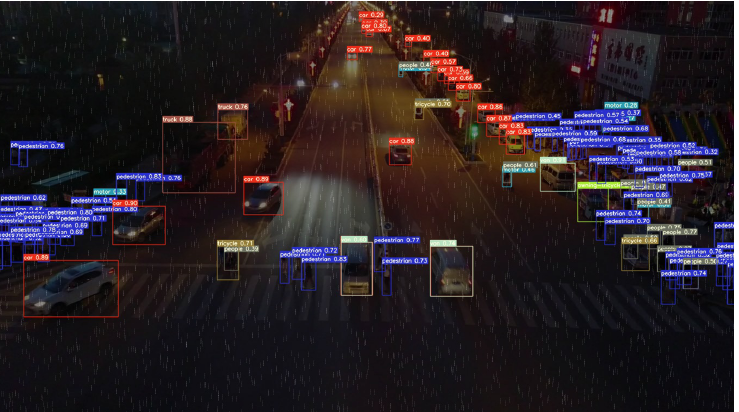
Figure 15. Visualization of detection results by applying CoDerainNet to a low-light rainy image in